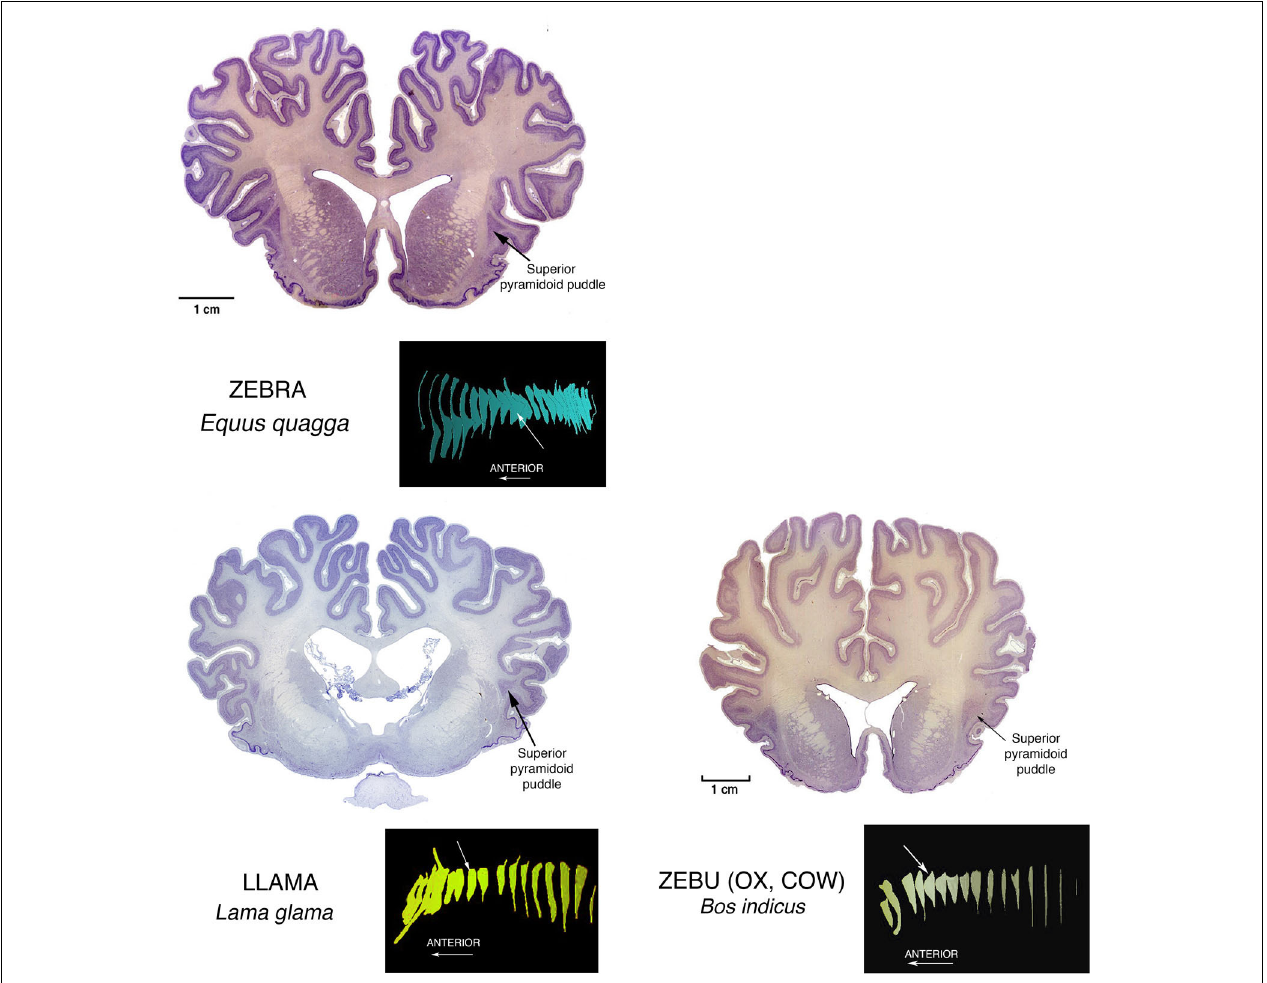
FIGURE 3 | Nissl stained coronal sections through the brains of perissodactyl Zebra, and artiodactyl Llama and Zebu (Ox, Cow) illustrating other instances of Superior Pyramidoid puddles. The white arrows in the reconstructions mark the positions of the illustrated sections in the anterior-posterior extents of the claustrums. This puddle shape along the superior aspect of the claustrum can occur anywhere